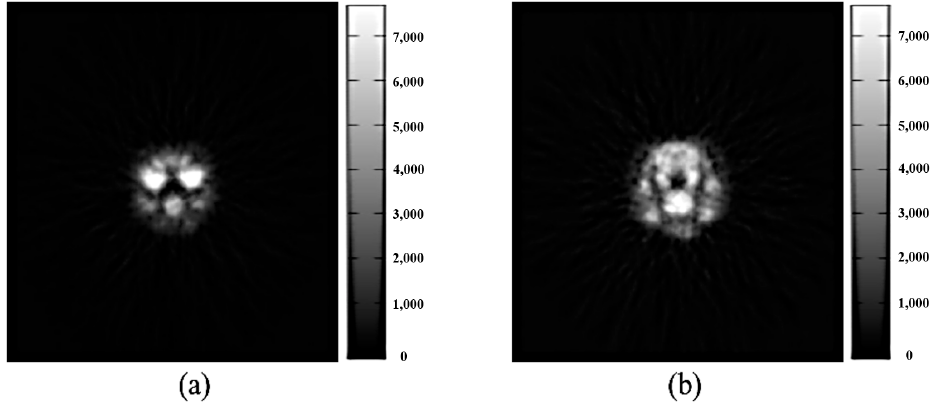
Figure 2. FBP images of the rats that were scanned using MicroPET R4 on the 1st ( a ) and 32nd ( b ) slices.